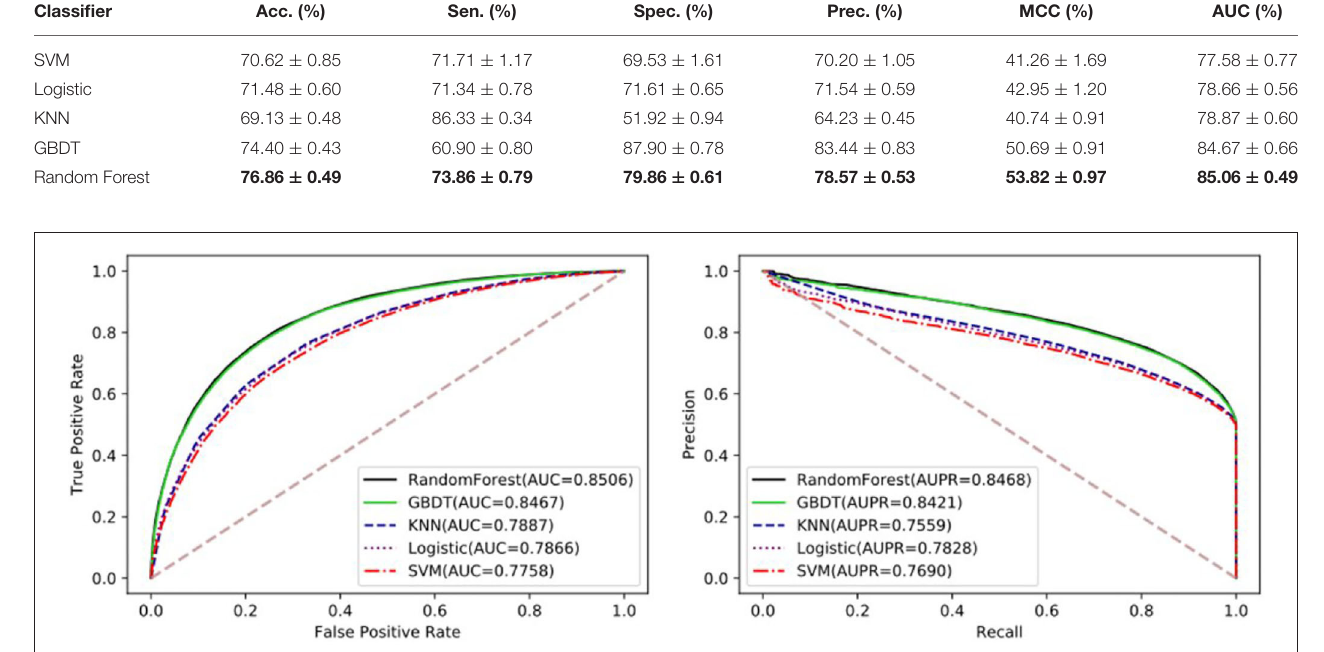
FIGURE 4 | The performance comparison between Random Forest and GDBT, KNN, Logistic Regression, and SVM.